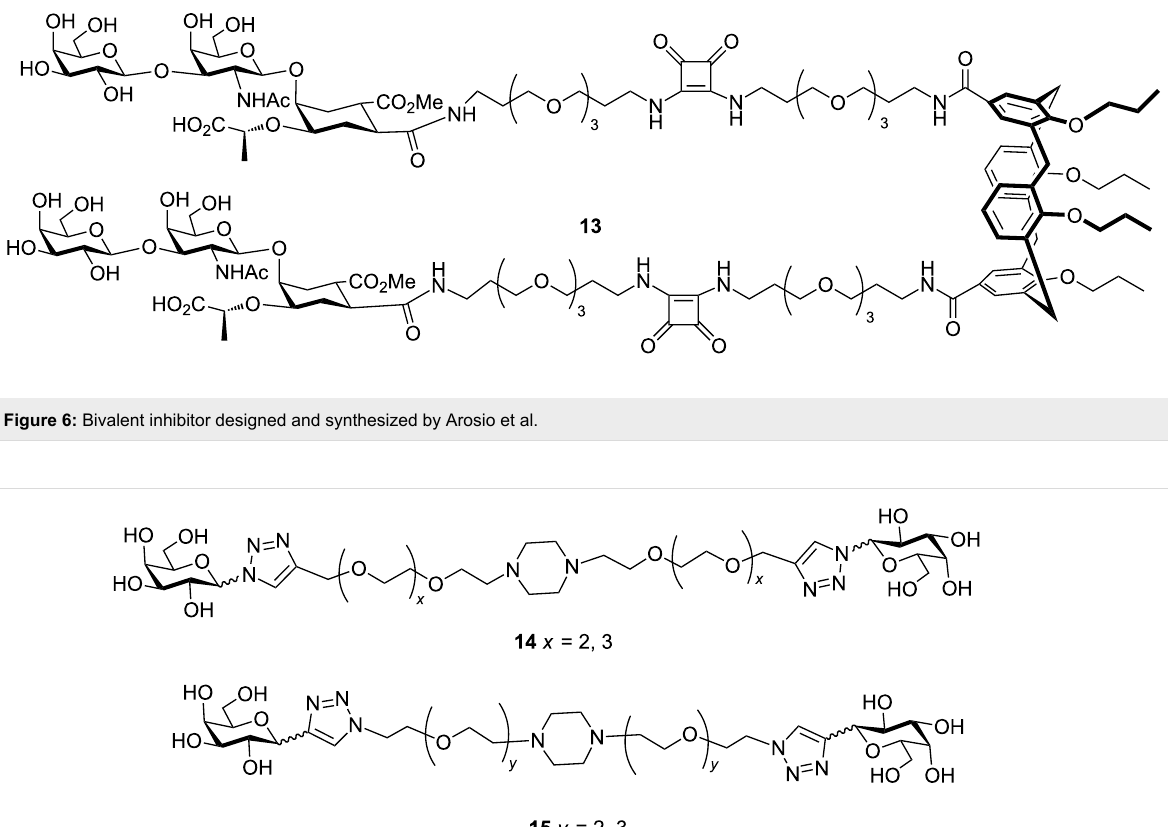
tetravalent multivalent inhibitors and showed substantial gains in binding affinity in comparison to the corresponding monova- lent ligands. Pieters and co-workers attached a lactose-derived monomeric ligand to the dendrimer 18 , and found that there was an affinity and potency gain from divalent and tetravalent mole- cules [51]. Even the galactose containing dendrimers 20 bind as